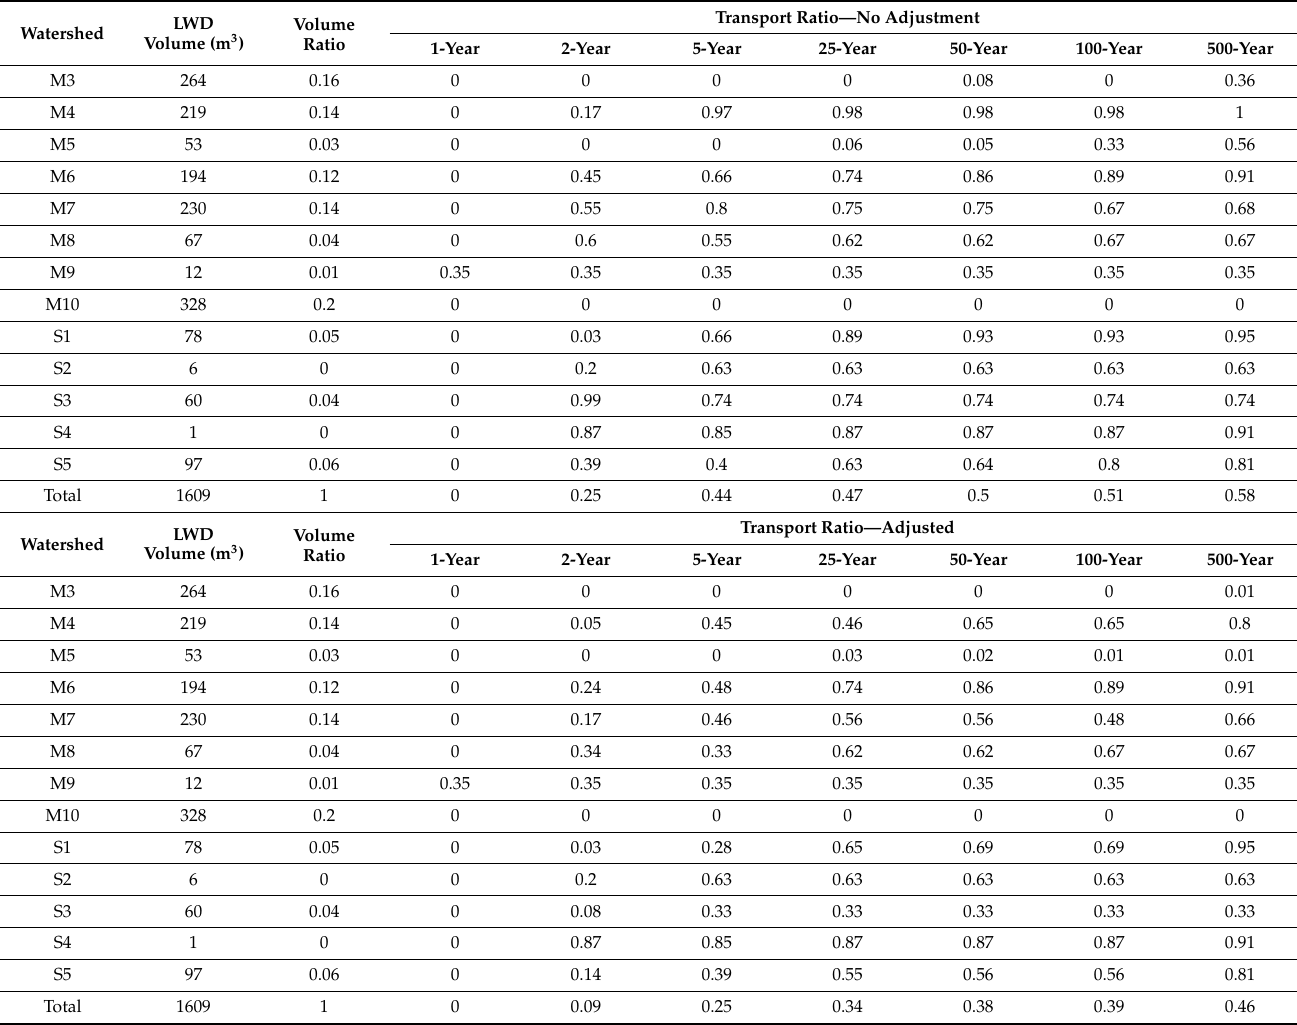
Table 3. Summary of LWD transport ratio to the available LWD volume at each